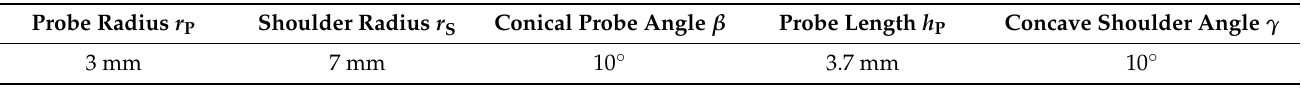
Table 1. Relevant tool